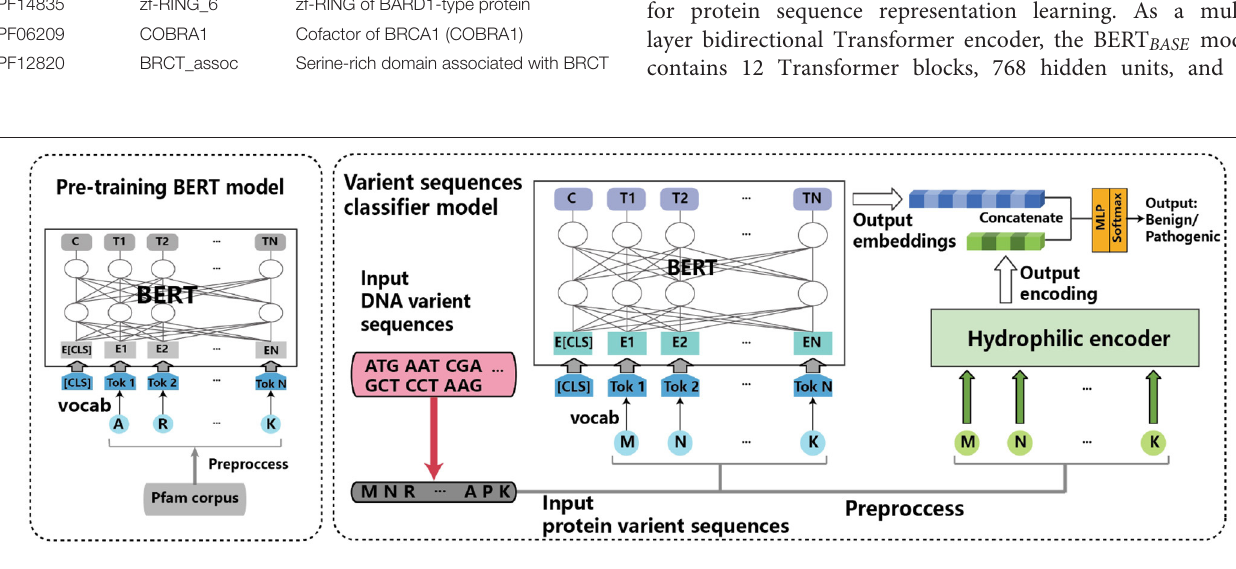
FIGURE 1 | The overview of our proposed